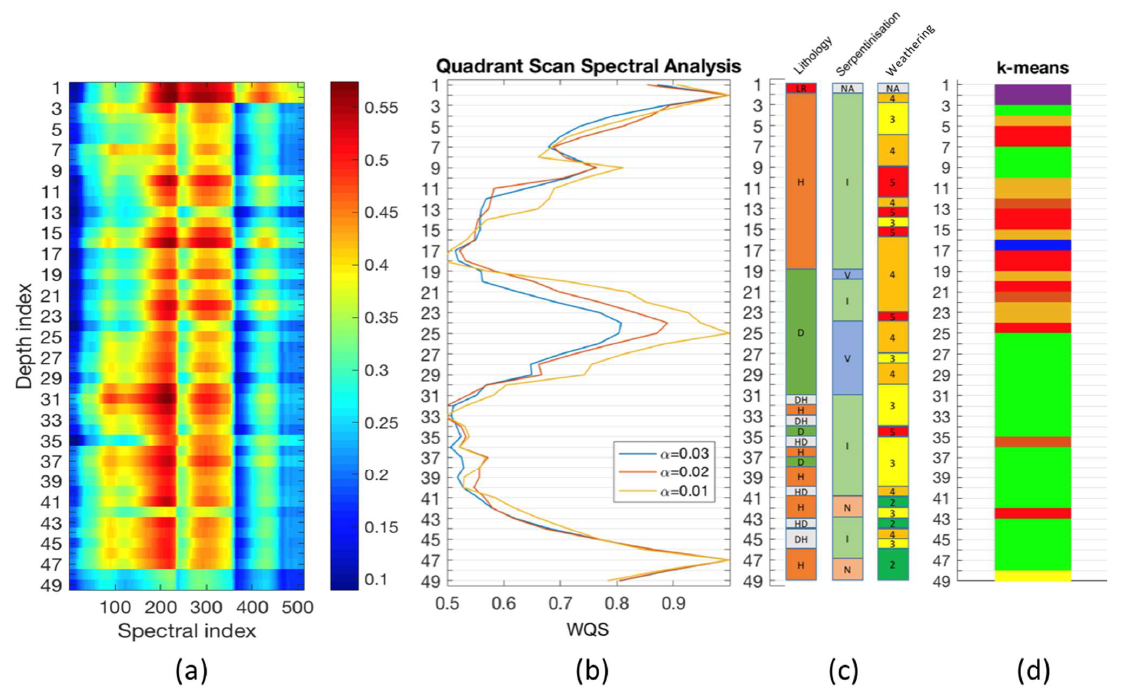
Figure 5. Tests to determine the optimal number of clusters for the k-means method. ( a ) The Bayes- ian Information Criterion (BIC) test shows that 8 is the optimal number of clusters at which the testing criterion is minimal, and; ( b ) The Elbow method test: it shows the Residual Sum of Squares error (RSS) as a function of the number of clusters.